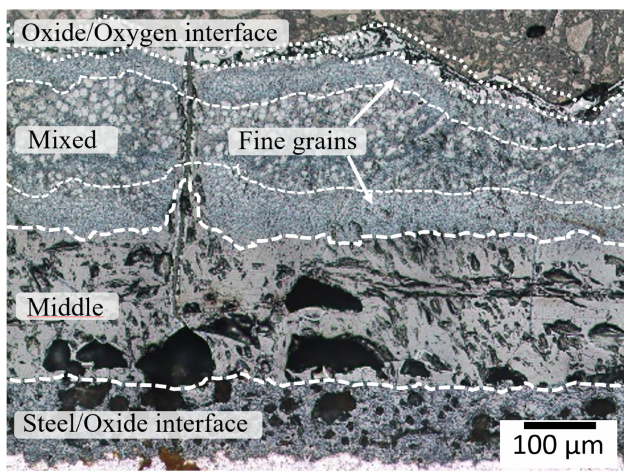
Figure 11. Optical micrograph used during nanoindentation tests.